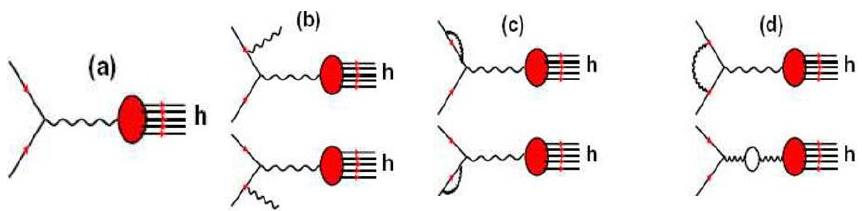
Figure 1. The Feynman diagrams of e + e − annihilation into hadrons up to one-loop order: (a) the tree level diagram, (b) the bremsstrahlung, (c) electron self-energy, (d) vertex correction and vacuum